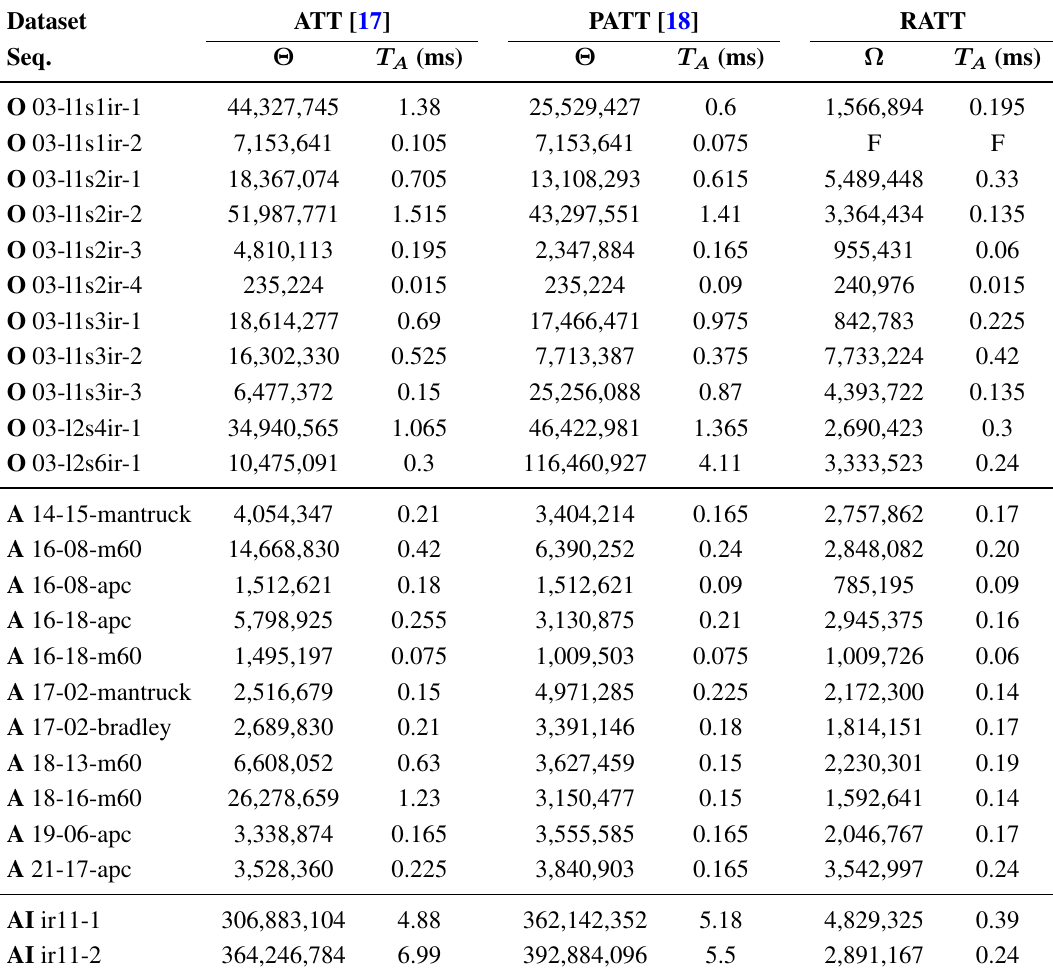
Table 3. A comparison of the number of estimated operations ( Θ and Ω ) and the real average time per frame T among the proposed algorithm and the reference ones ATT [17] and A PATT [18]. O, OTCBVS dataset; A, AMCOM dataset; AI, AIC dataset. Dataset ATT [17] PATT [18] RATT